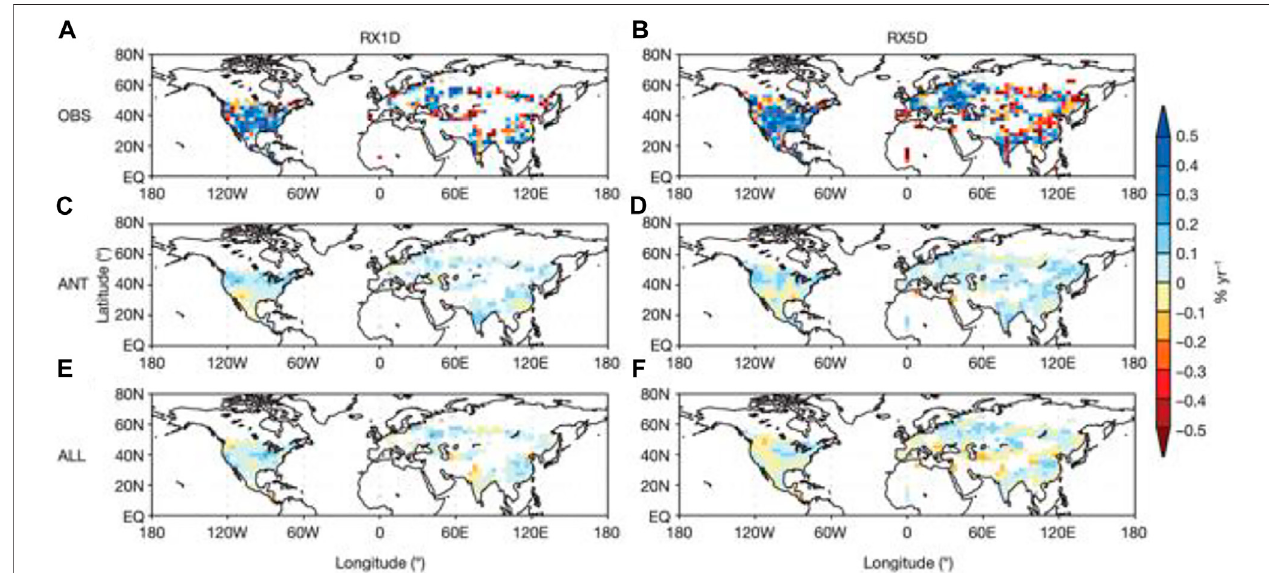
FIGURE11| Comparisonofgeographicaltrendsofextremeprecipitationindicesfor1951-1999forannualmaximumdaily(RX1D)and fi ve-dayRX5D)precipitation amounts. (A, B) Observations, (C, D) model simulations, and (E, F) combined for observations (OBS), anthropogenic forcing (ANT), and anthropogenic plus natural forcings (ALL) (from Min et al., 2011, Reprinted by permission).